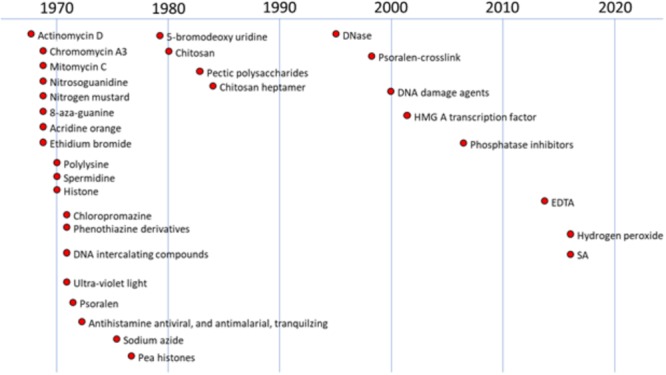
History of studies regarding anti-cancer and other compounds on DNA damage in plants. The figure were created based on the following references (chronological order): Schwochau and Hadwiger, 1968, 1969; Hadwiger and Schwochau, 1970, 1971; Hadwiger and Martin, 1971; Hess and Hadwiger, 1971; Hadwiger, 1972a,b; Hadwiger et al., 1976, 1977, 1995; Sander and Hadwiger, 1979; Hadwiger and Beckman, 1980; Walker-Simmons et al., 1983; Kendra et al., 1989; Parsons and Hadwiger, 1998; Choi et al., 2001; Klosterman et al., 2003; Hartney et al., 2007; Hadwiger and Tanaka, 2015; Hadwiger and Tanaka, 2017b; Tanaka and Hadwiger, 2017.